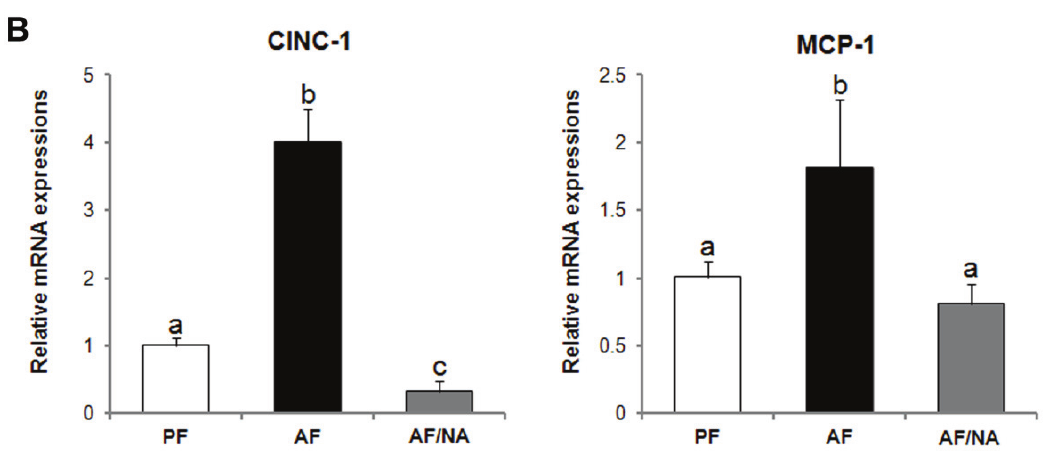
Figure 2. Hepatic gene expression of endotoxin signaling molecules ( A ) and cytokines ( B ) in rats fed alcohol with or without nicotinic acid supplementation for 8 weeks. Gene expression was assessed by qPCR assay of the mRNA level. Results are means ± SD ( n = 6–8). Significant differences ( p < 0.05, ANOVA) are identified by different letters. PF: pair-fed; AF: alcohol-fed; AF/NA: alcohol-fed with nicotinic acid supplementation; LBP: LPS binding protein.